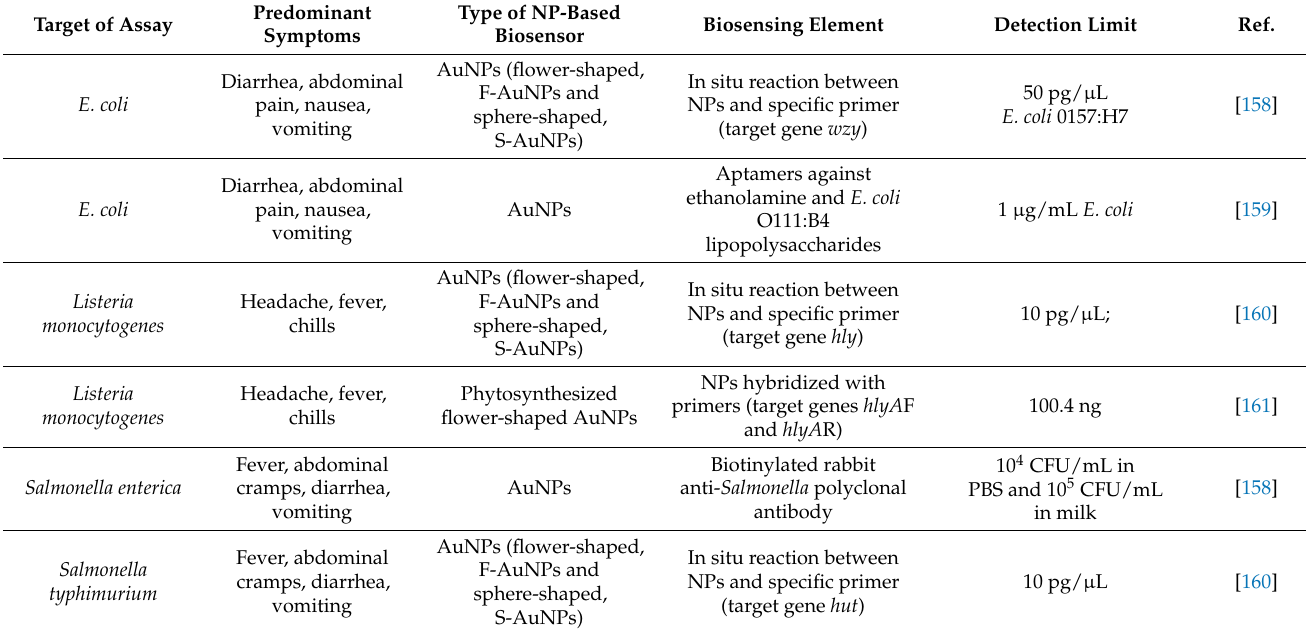
Table 1. Food-borne pathogen, predominant symptoms, and the metallic nanoparticles used for sensing food